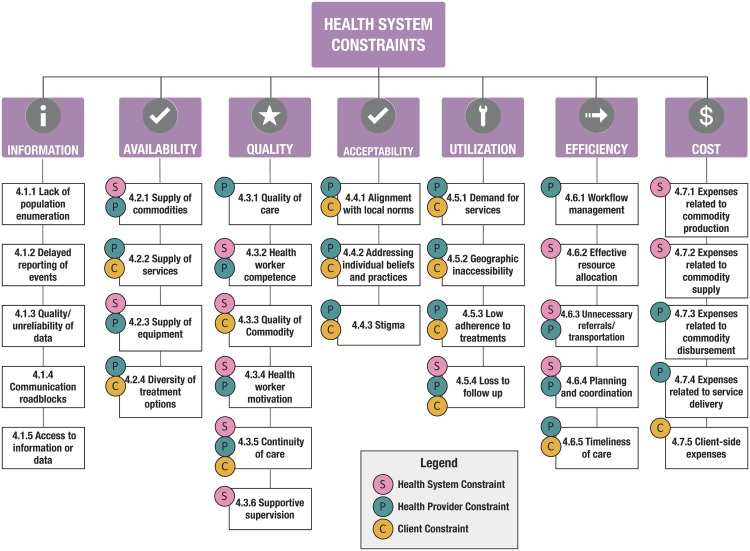
WHO Model Illustrating Health System ConstraintsSource: Mehl (2014).26